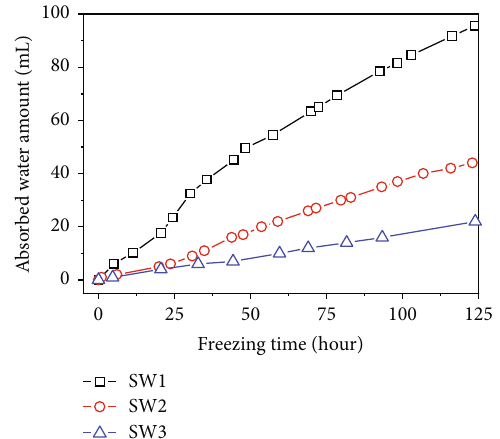
Figure 11: The water supplement during the freezing process of the